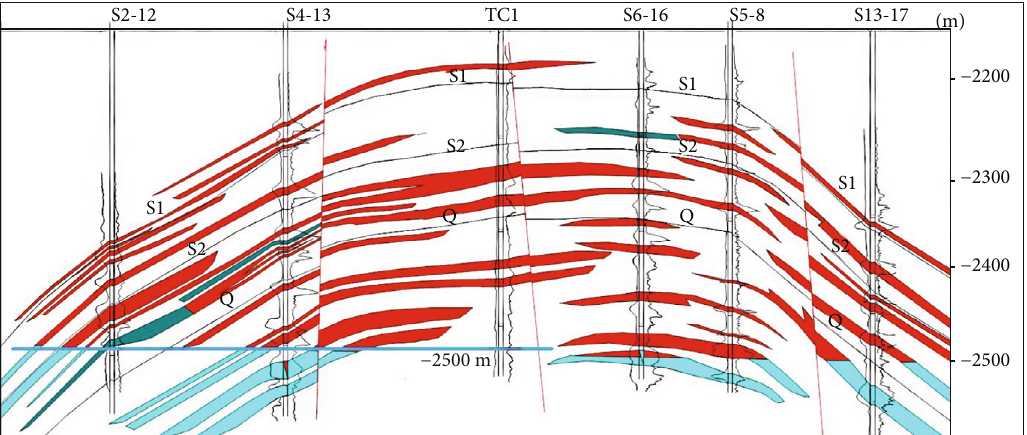
Figure 1: Geological structure of Ss reservoir.